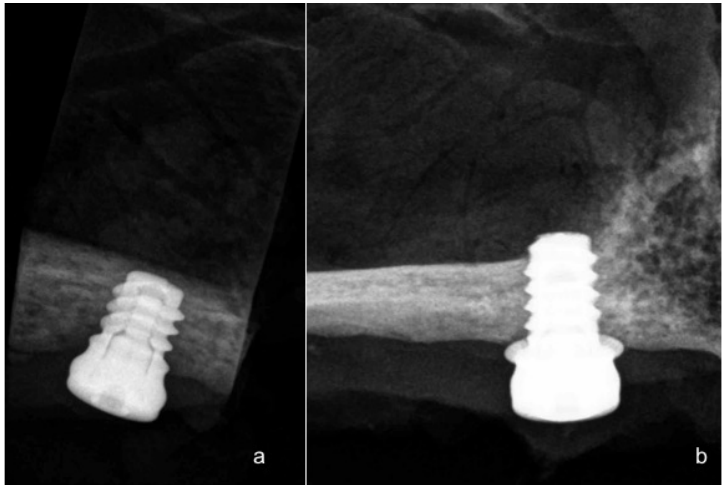
Figure 4. ( a ) Narrow ring extra-short implant radiograph after 90 days of evaluation; ( b ) Wide ring extra-short implant radiograph after 90 days follow-up.